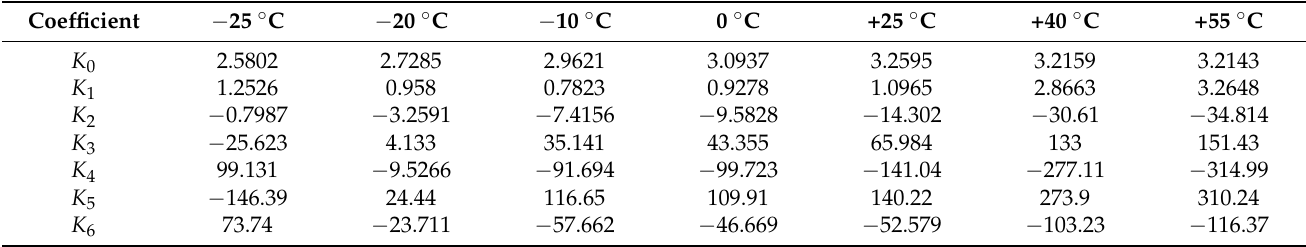
Table 2. Coefficient values under different operating